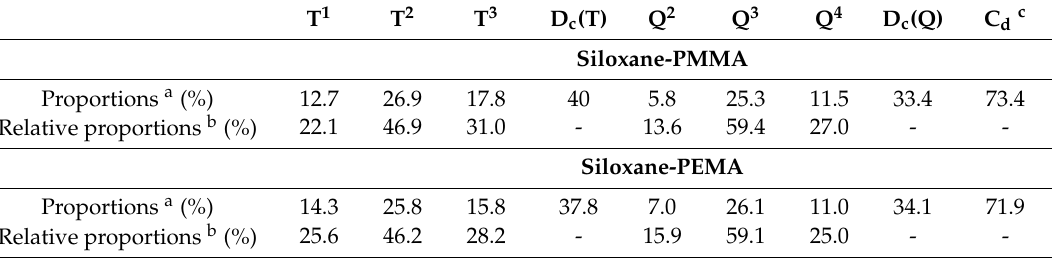
Proportions a (%) Relative proportions b (%)